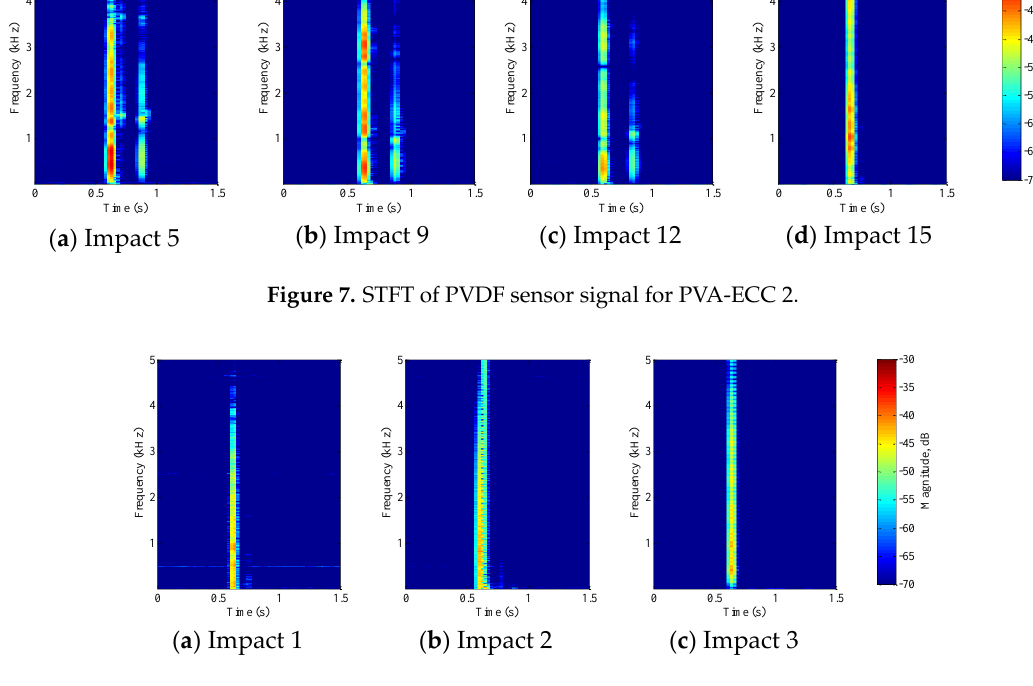
Figure 8. STFT of PVDF sensor signal for PVA-ECC 3.